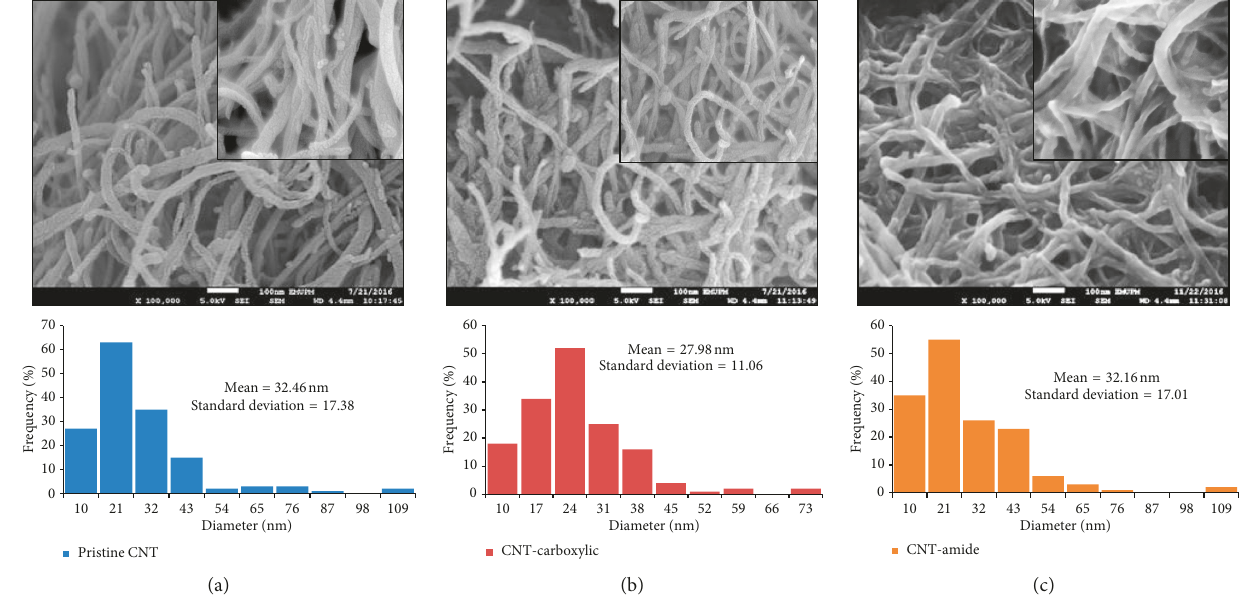
Figure 1: Micrographs of (a) pristine CNT, (b) CNT-carboxylic, and (c) CNT-amide. Table 1: Elemental composition of pristine and functionalized